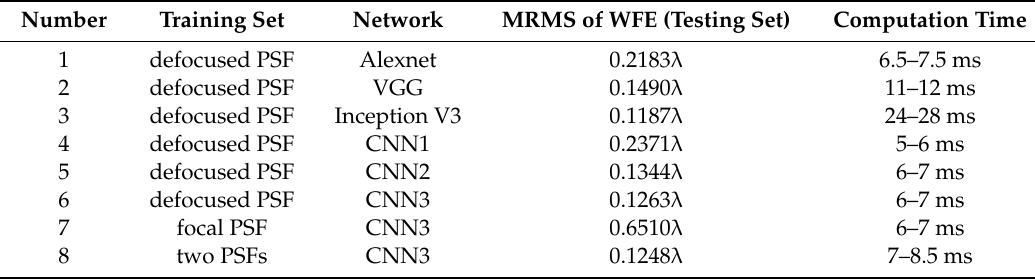
Figure 2. The wavefront of 4th to 64th Zernike coefficients. ( a ) The simulated wavefront; ( b – g ) the wavefront of reconstructions by Alexnet, VGG, Inception V3, CNN1, CNN2, and CNN3; ( h ) the focal plane point spread functions (PSF); and ( i ) the defocused PSF. Table 1. The wavefront errors of the